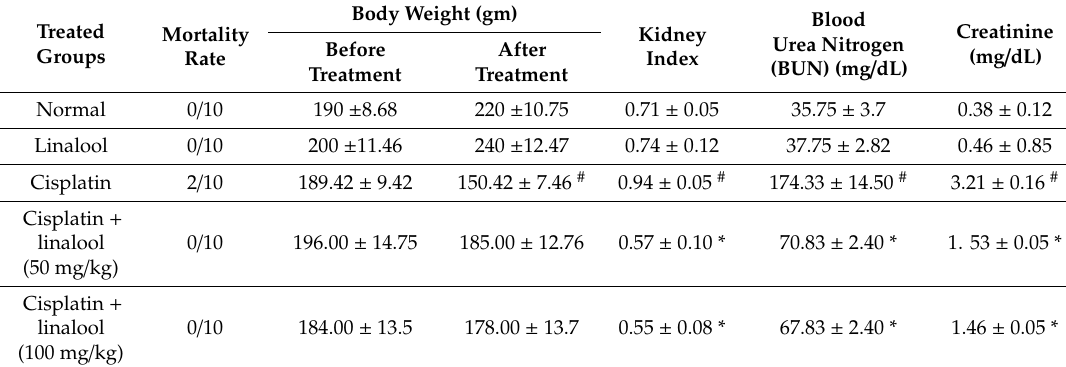
Table 2. E ff ects of linalool and cisplatin on renal function markers in rats.